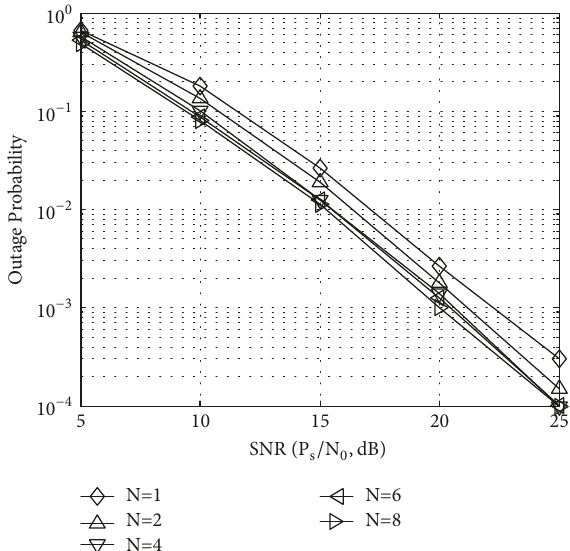
Figure 3: The outage probability of the ILAR